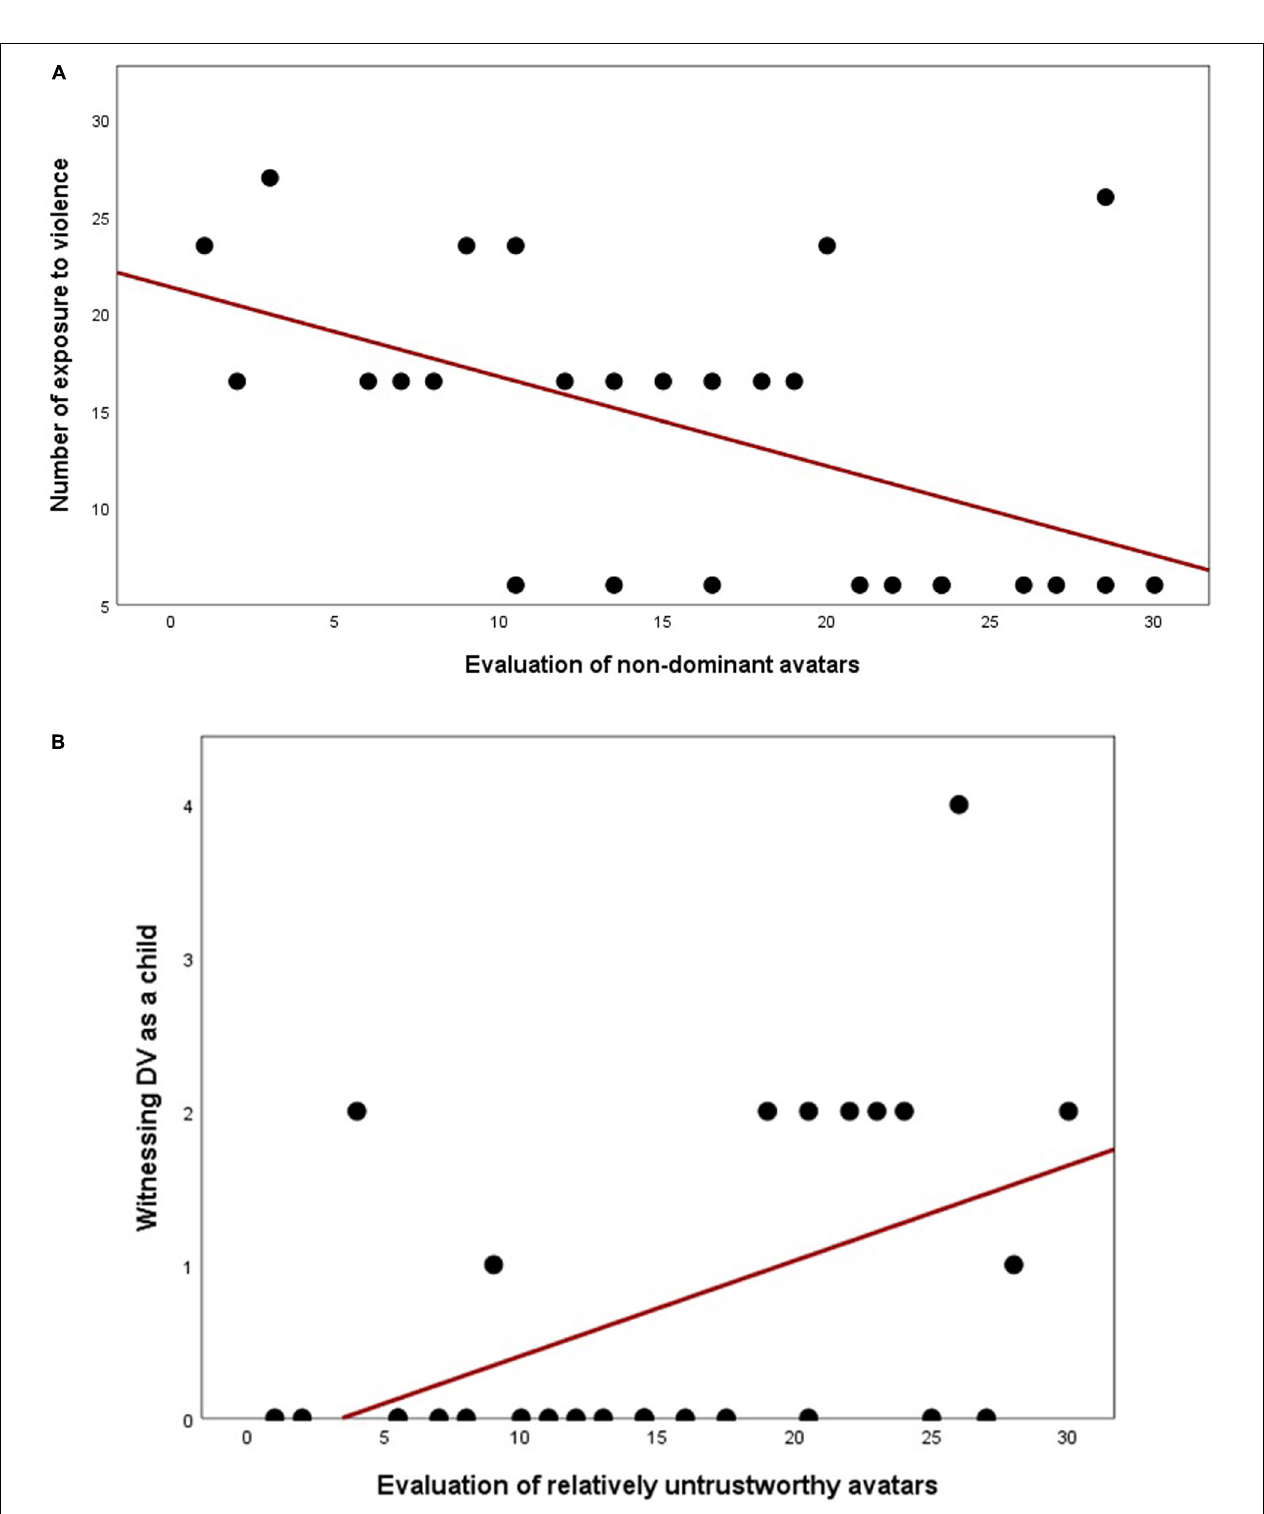
FIGURE 6 | Scatter plots rank-based Spearman’s correlations between participants’ evaluation of non-dominant avatars and exposure to violent events (A) and between evaluation of relatively untrustworthy avatars and witnessing domestic violence as a child (B) .